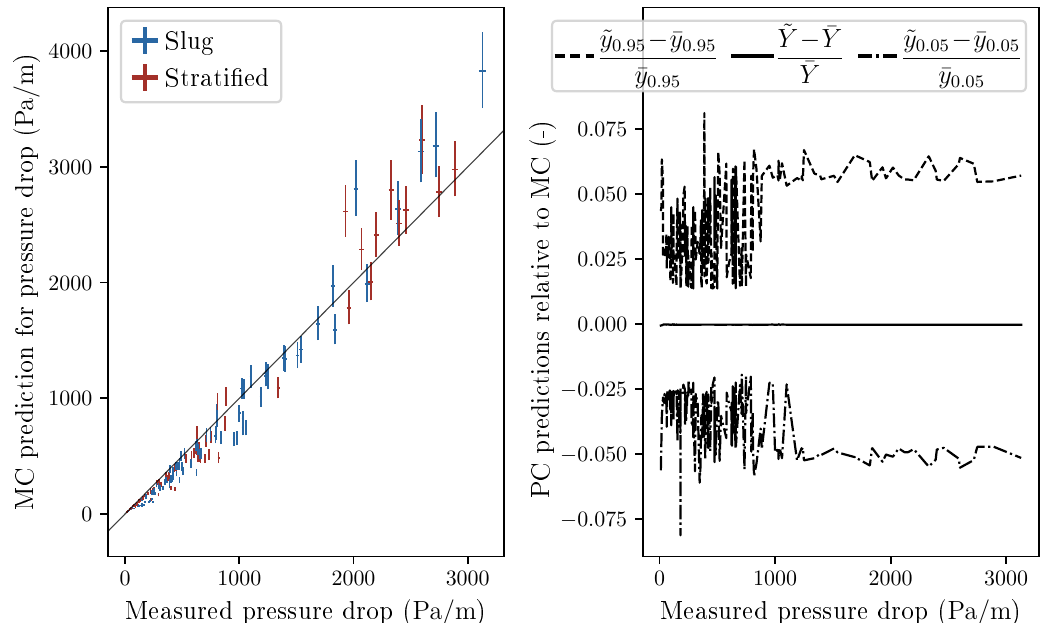
( a ) 90% prediction intervals.